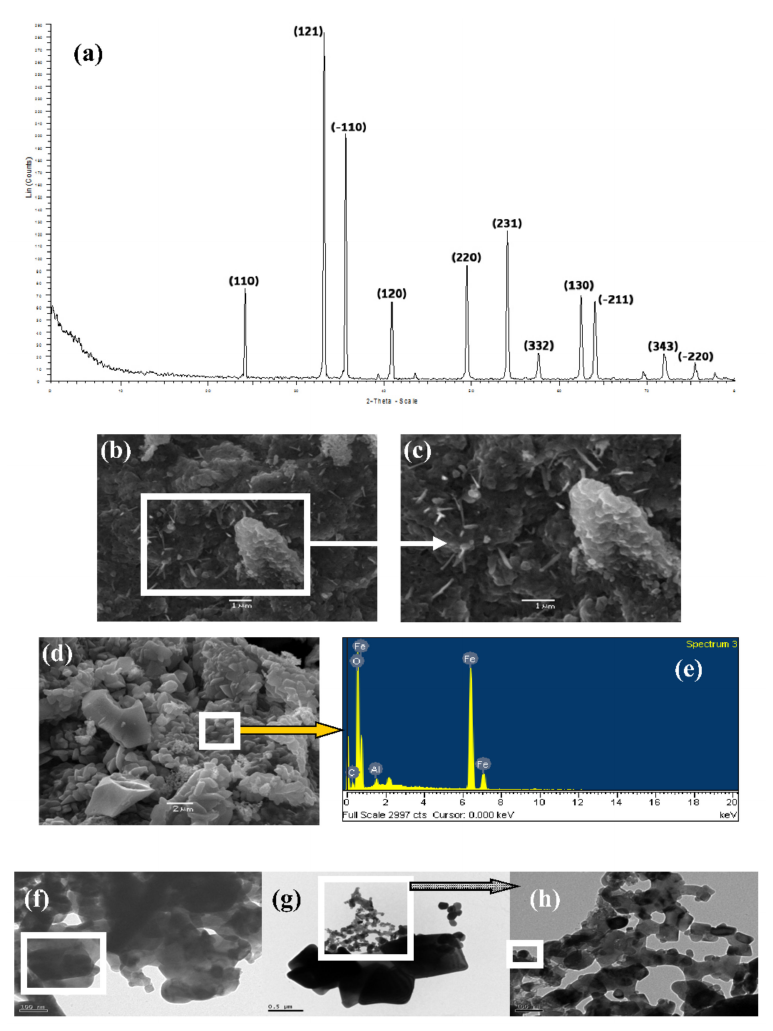
Figure 6. XRD ( a ), SEM analysis ( b – d ), EDS ( e ), and TEM image ( f – h ) for the pyrolytic product